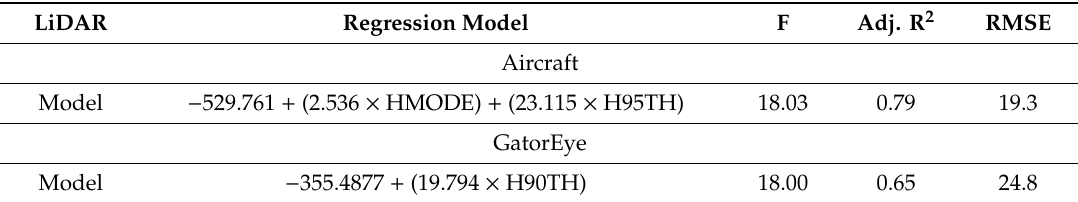
Table 5. Regression models for aboveground biomass (AGB; Mg · ha − 1 ) relating field-estimated AGB and forest metrics calculated with aircraft and GatorEye LiDAR data.